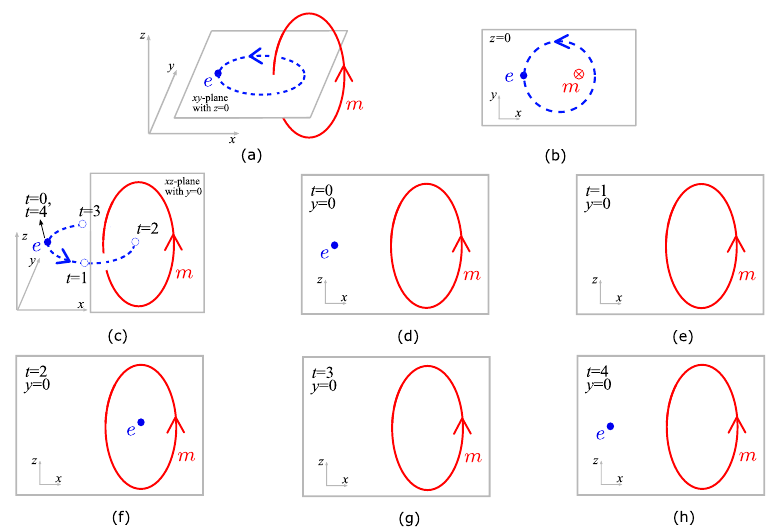
Figure 2 . A particle-loop braiding in 3 D space and its projection on 2 D planes. (a) Particle-loop braiding is one important braiding process in 4 D topological order. In this braiding process, if we assume the loop m to be static, what we see is that the particle e encircles the loop such that its spatial trajectory and loop m form a Hopf link. (b) For an observer living on the xy -plane with z = 0 , the particle-loop braiding in 3 D appears as a particle e encircling a flux that penetrates this plane. (c) The same particle-loop braiding in 3 D space as that in (a). The particle’s positions at different moments are labeled. (d)-(e) Snapshots of particle-loop braiding observed in xz -plane with y = 0 at different moments. In this plane, the loop excitation appears as its complete form while the spatial trajectory of the particle is not continuous any longer. An observer living on this plane can only see the particle at t = 0 , 2 , 4 . At t = 1 or t = 3 , this particle is located at xz -planes with different y -coordinates. To this planar observer’s knowledge, a particle cannot cross a loop